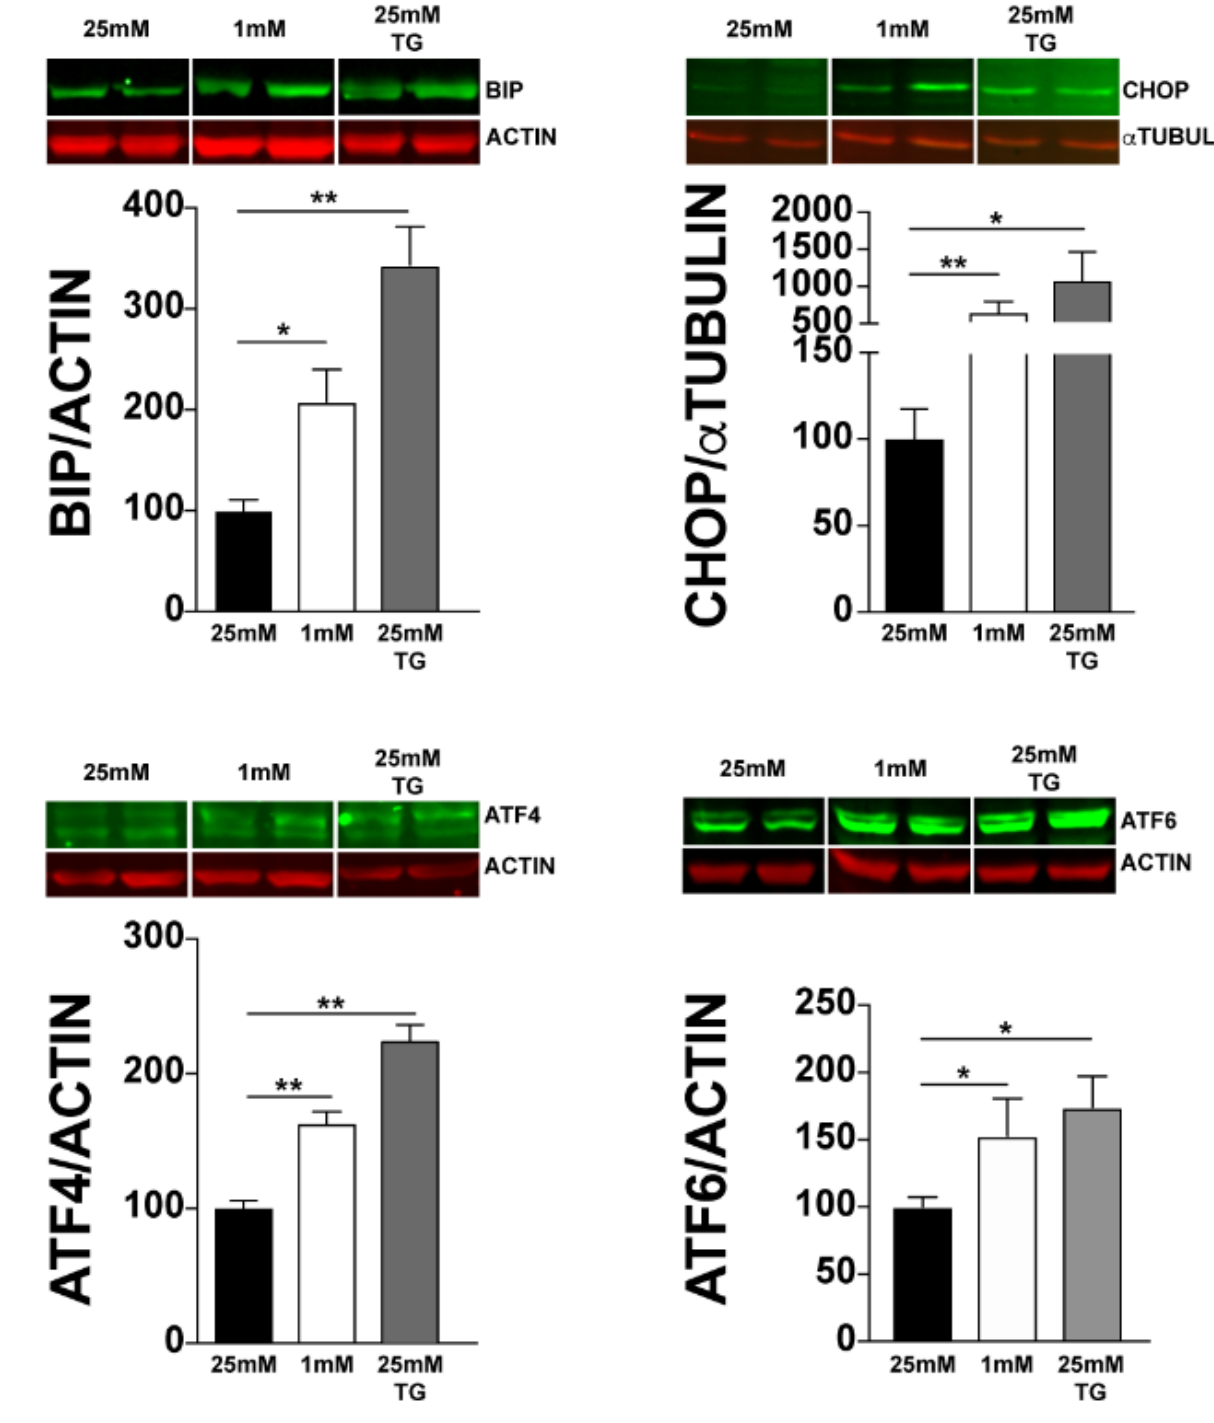
Figure 2. Effect of low glucose conditions on the expression of ER stress proteins. Protein levels from 661W cell lysates were evaluated using Western blotting analysis, with β -actin and α -tubulin for normalisation. Results are expressed as mean ± SEM of three experiments ( n = 6; * p < 0.05, ** p < 0.009).